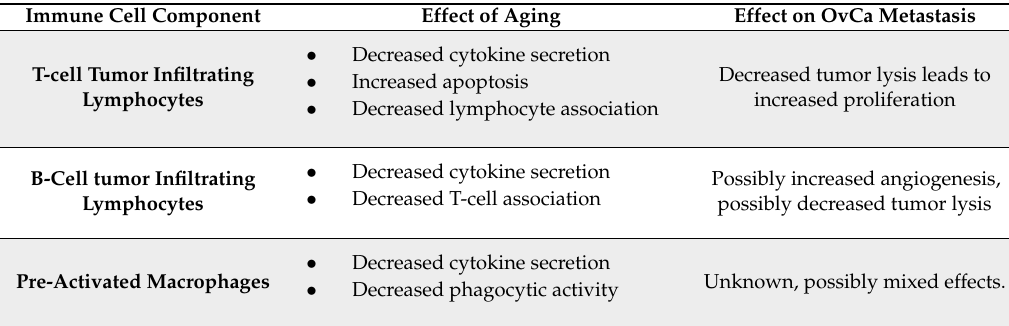
Table 1. Summary of aging-related immune